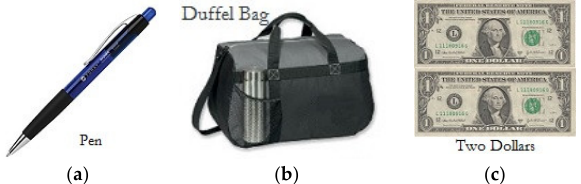
Figure 1. The item pictures that subjects saw during the experiment. Pictures are of the actual item they would receive. ( a ) A pen; ( b ) A duffel bag; ( c ) $2 in cash.